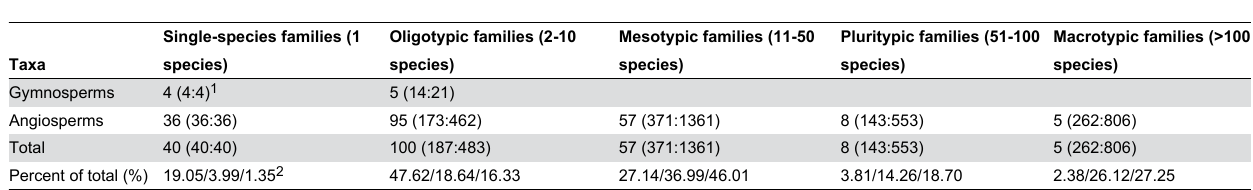
Table 7. Statistics of the family size from the seed plant flora of Mount Jinggangshan